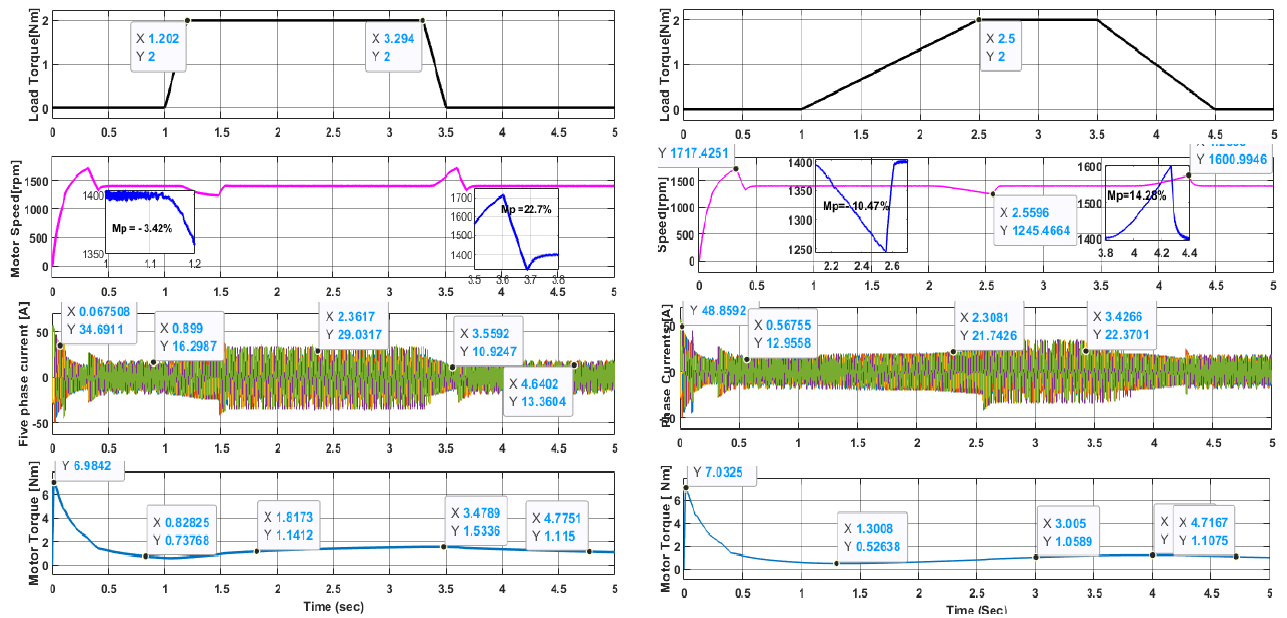
Figure 6. Transient performance of the drive with a PI controller.